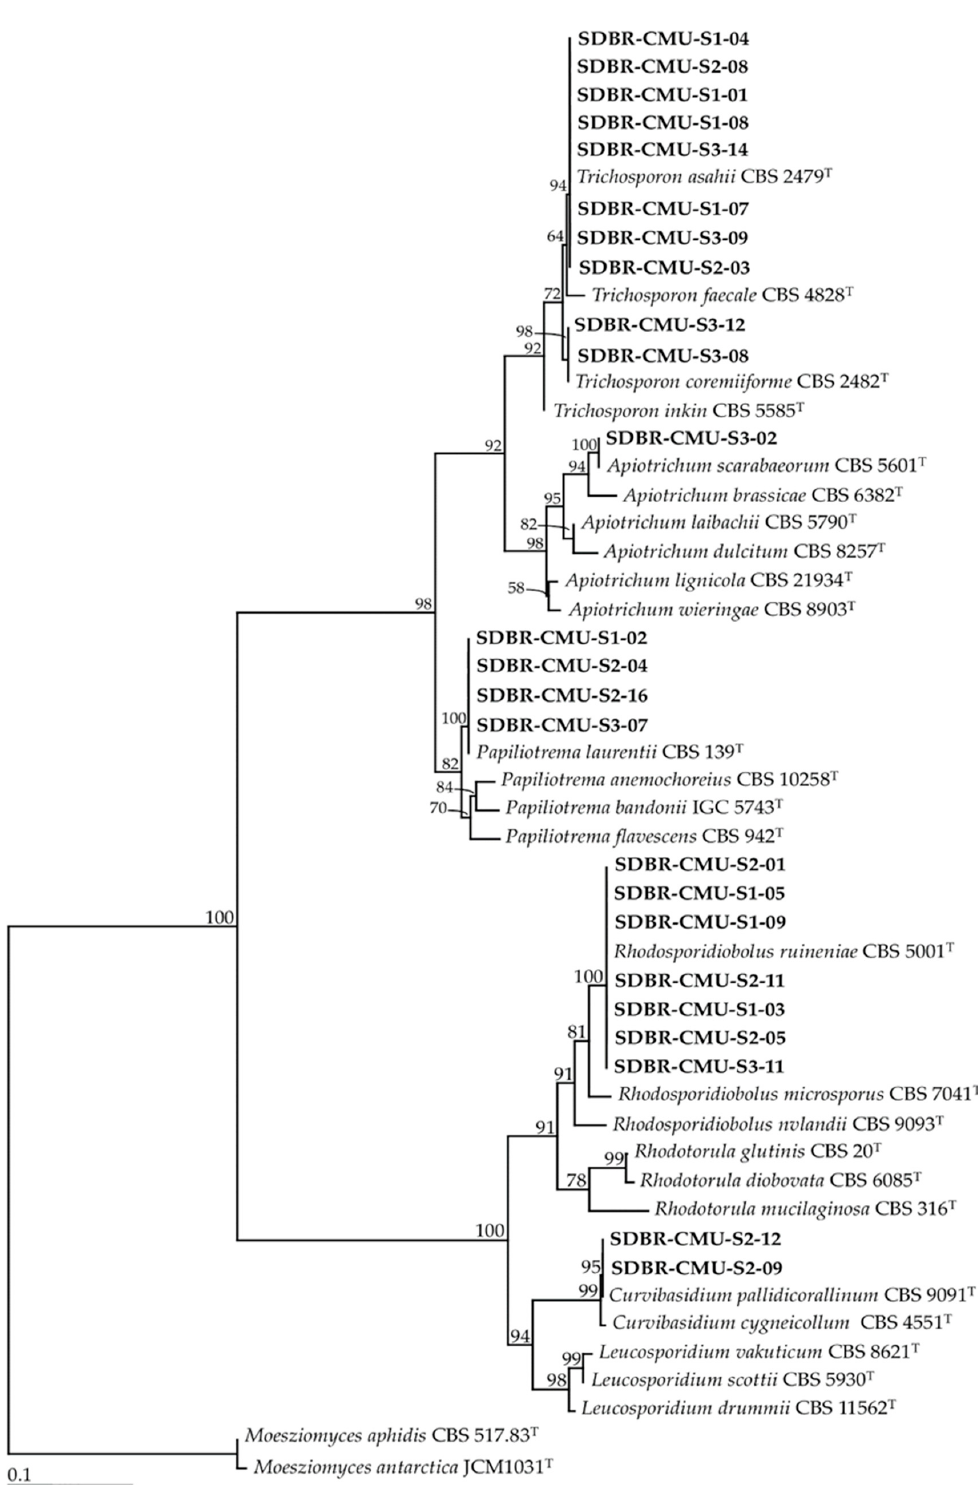
Figure 2. Phylogenetic tree of basidiomycetous yeast derived from maximum likelihood analysis of the D1/D2 region of the LSU rRNA gene. Rhodotorula mucilaginosa and R. diobovata were used as outgroup. Numbers above branches are the bootstrap statistics percentages. Branches with bootstrap values ≥ 50% are shown at each branch and the bar represent 0.1 substitutions per nucleotide position. The yeast strains obtained in this study are in bold. Superscription “T” means the type species.